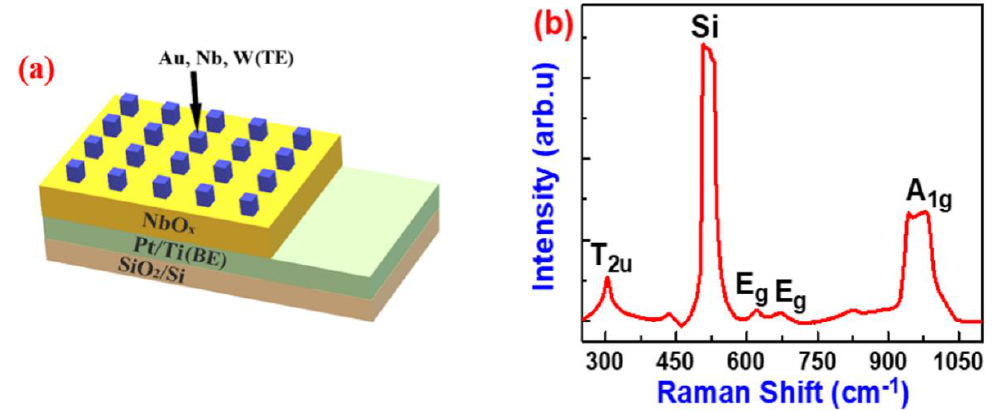
Figure 1. ( a ) Schematic illustration of NbO x -based devices. ( b ) Raman shift spectra of as-prepared NbO x with Pt as a bottom electrode (BE) measured at room temperature.